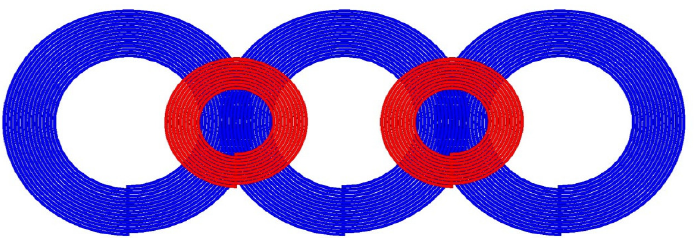
Figure 6. Rx coil position: 7.5 cm. Both Rx coils have almost the same mutual inductance with the Tx